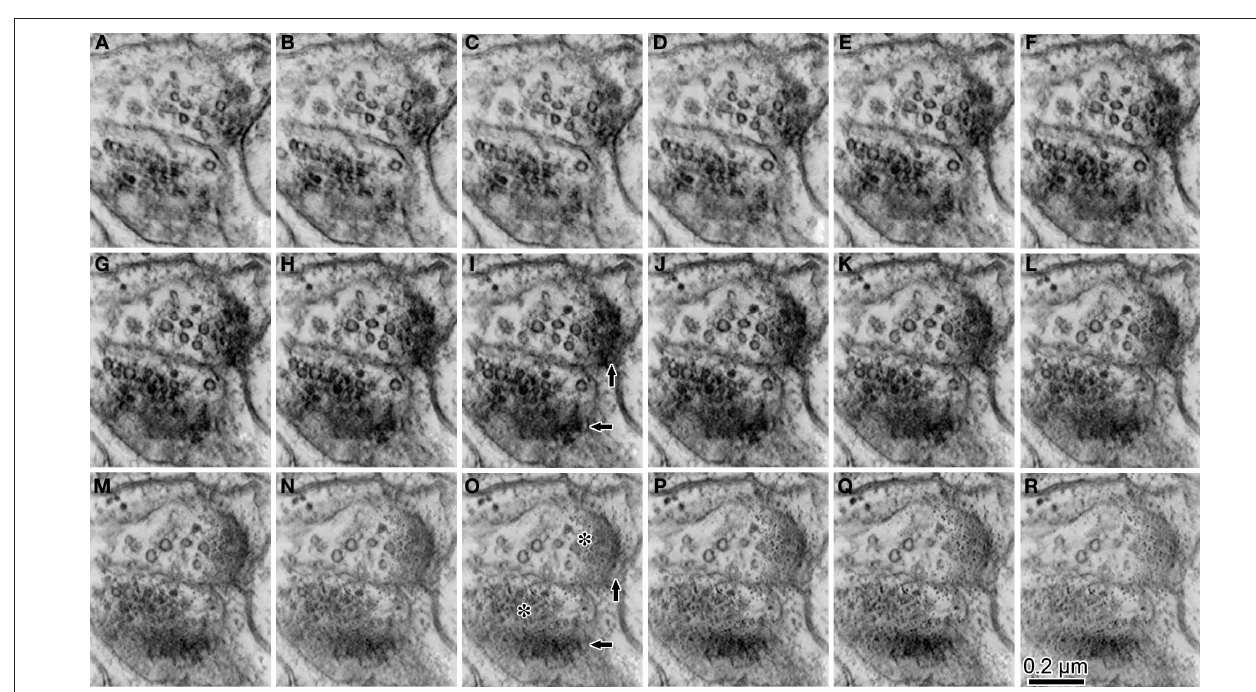
FIGURE 5 | The serial z-slice sections obtained by the tomography analysis showing the synaptic boutons shown in Figure 3L. We picked up 16 z-slice sections (A–R) of good quality from the middle of the z-slice sequence. The estimated thickness of the z-slice section is 1.75 nm . Some of the small vesicles ( ∼ 35 nm) emerge and disappear within the series, and presynaptic grids are seen.